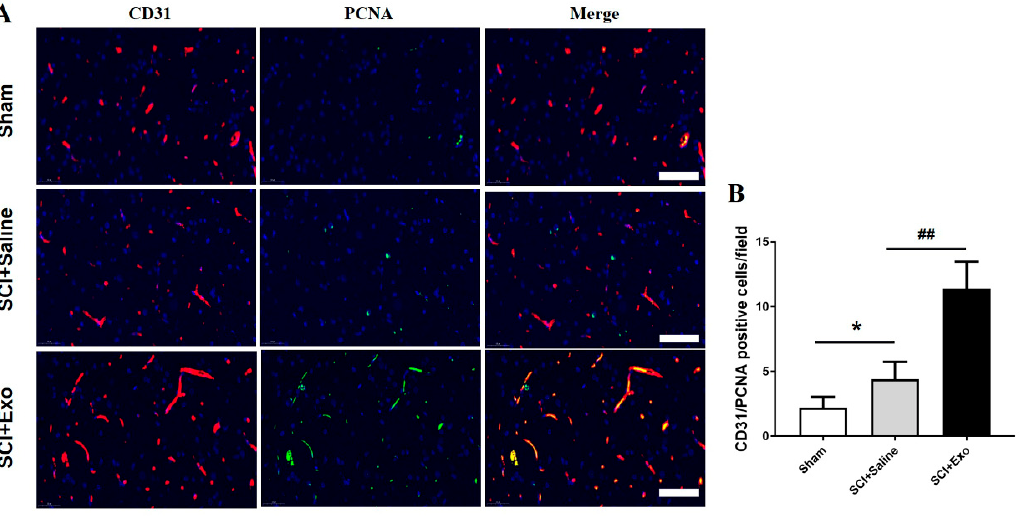
Figure 4. The administration of M2 macrophage exosome-induced endothelial cell proliferation after SCI in vivo. Representative images of PCNA+ (green) and CD31+ (red) cells in the anterior horn of the SC after 3 days of SCI ( A ). Quantification of PCNA/CD31+ cells in the injured SC ( B ). Mean ± SD. * p < 0.05 SCI + saline group versus sham group, ## p < 0.01 SCI + Exo versus saline group. N = 5 per group. Bar = 50 μ m.